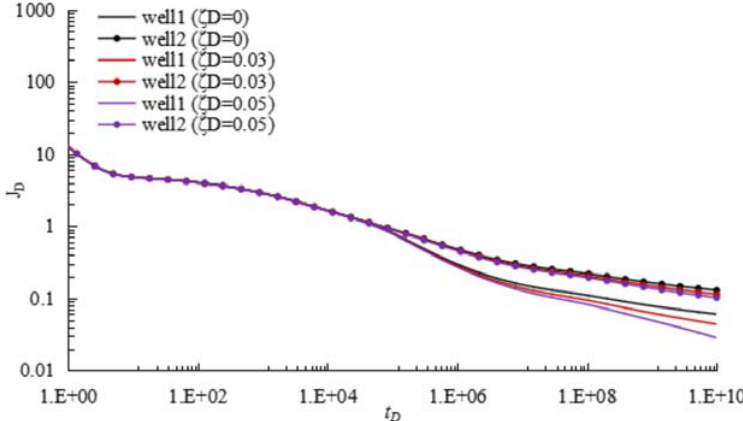
Figure 13. Effects of stress sensitivity coefficient on MPI for WIPS scheme.